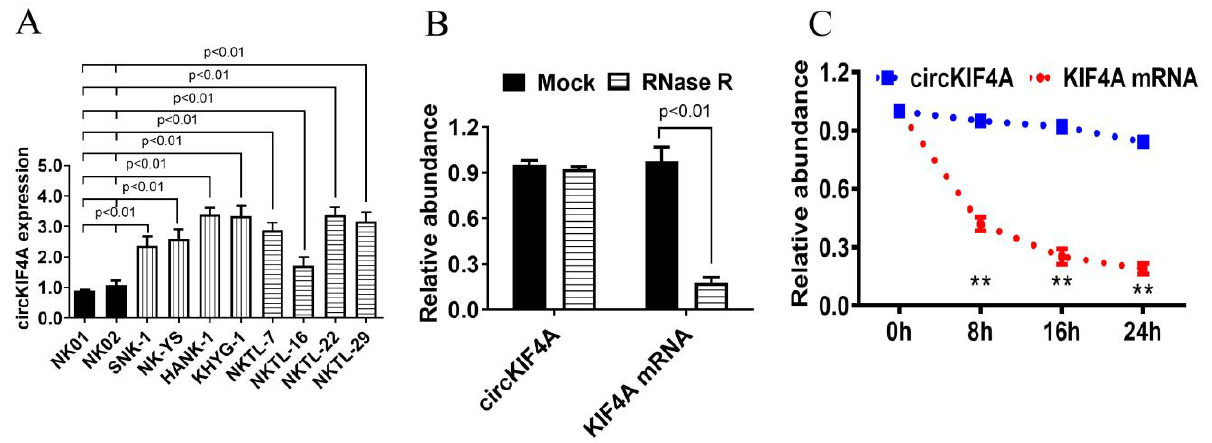
Figure 1. CircKIF4A is upregulated in NKTL. ( A ) CircKIF4A expression in the NKTL cell lines, SNK-1, NK-YS, HANK-1, KHYG-1, NKTL-7, NKTL-16, NKTL-22, and NKTL-29, and the normal NK cell lines, NK01 and NK02. ( B ) RNase R analysis of the circKIF4A and KIF4A mRNA. ( C ) Actinomycin D treatment was used to determine the stability of circKIF4A. ** indicates p <